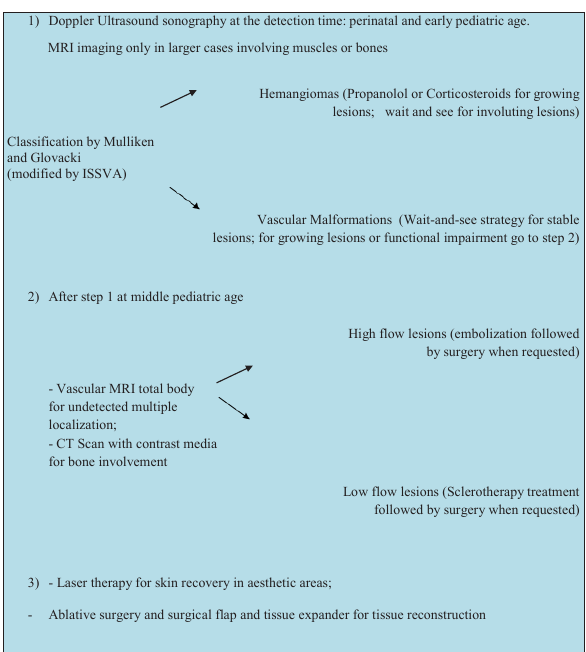
Table 1: Diagnostic-therapeutic